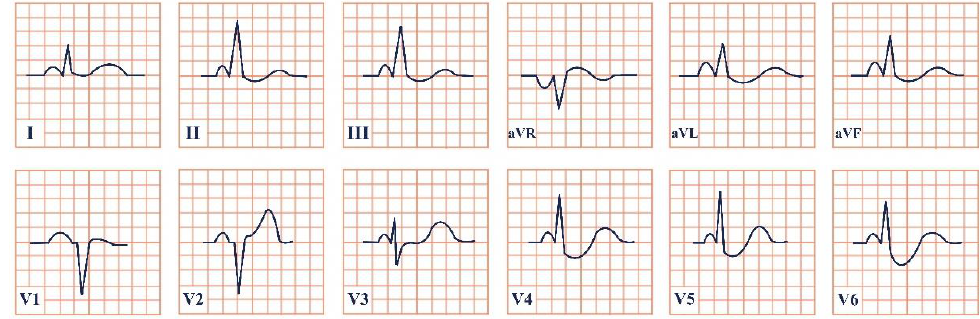
Figure 7. Electrocardiogram aspect in Lown – Ganong – Levine